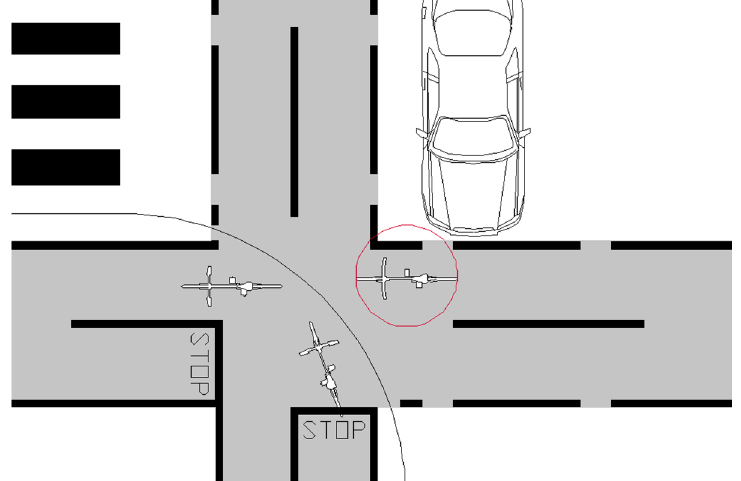
Figure 8. Conflict points.